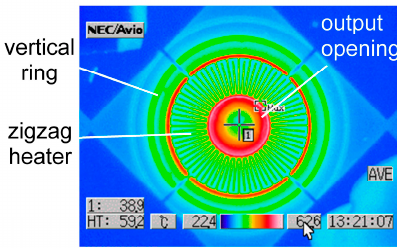
Figure 7. Thermography image of one microheater driven at 17 mW (15 V, 1.13 mA). A NEC Avio TVS-500 EX with microscope lens was used.